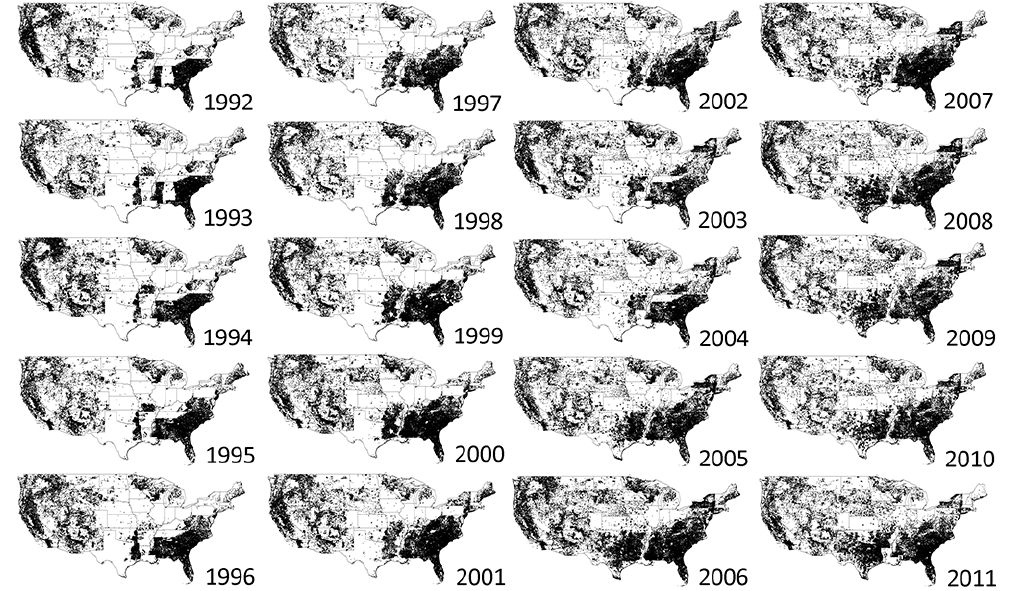
Figure 1. Locations of wildfire records from the conterminous US included in the FPA FOD by